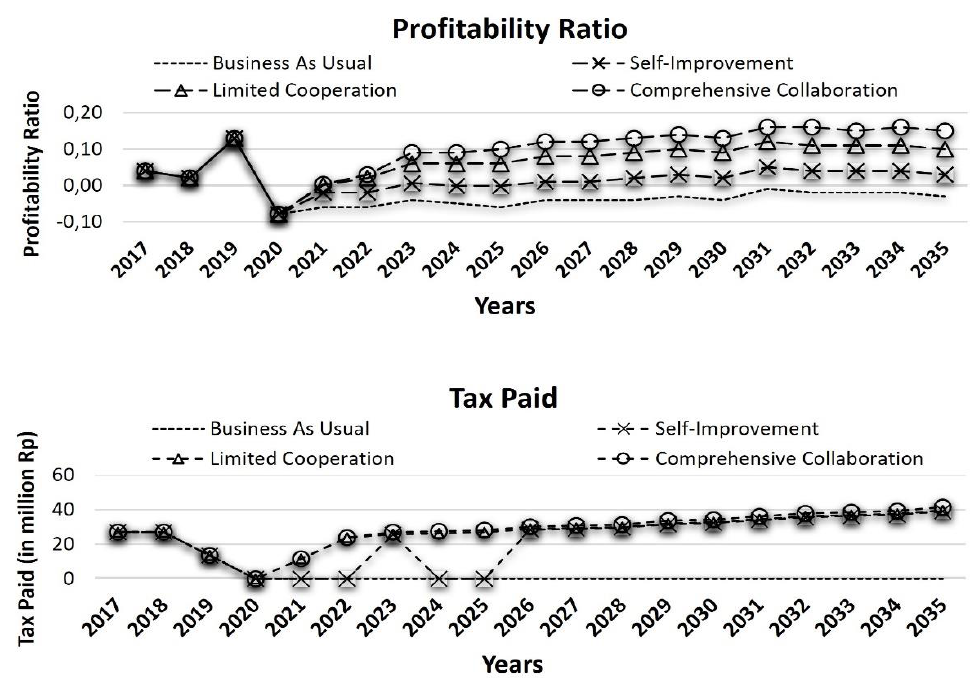
Figure 8. Strategies’ performances in the high material purchase price.